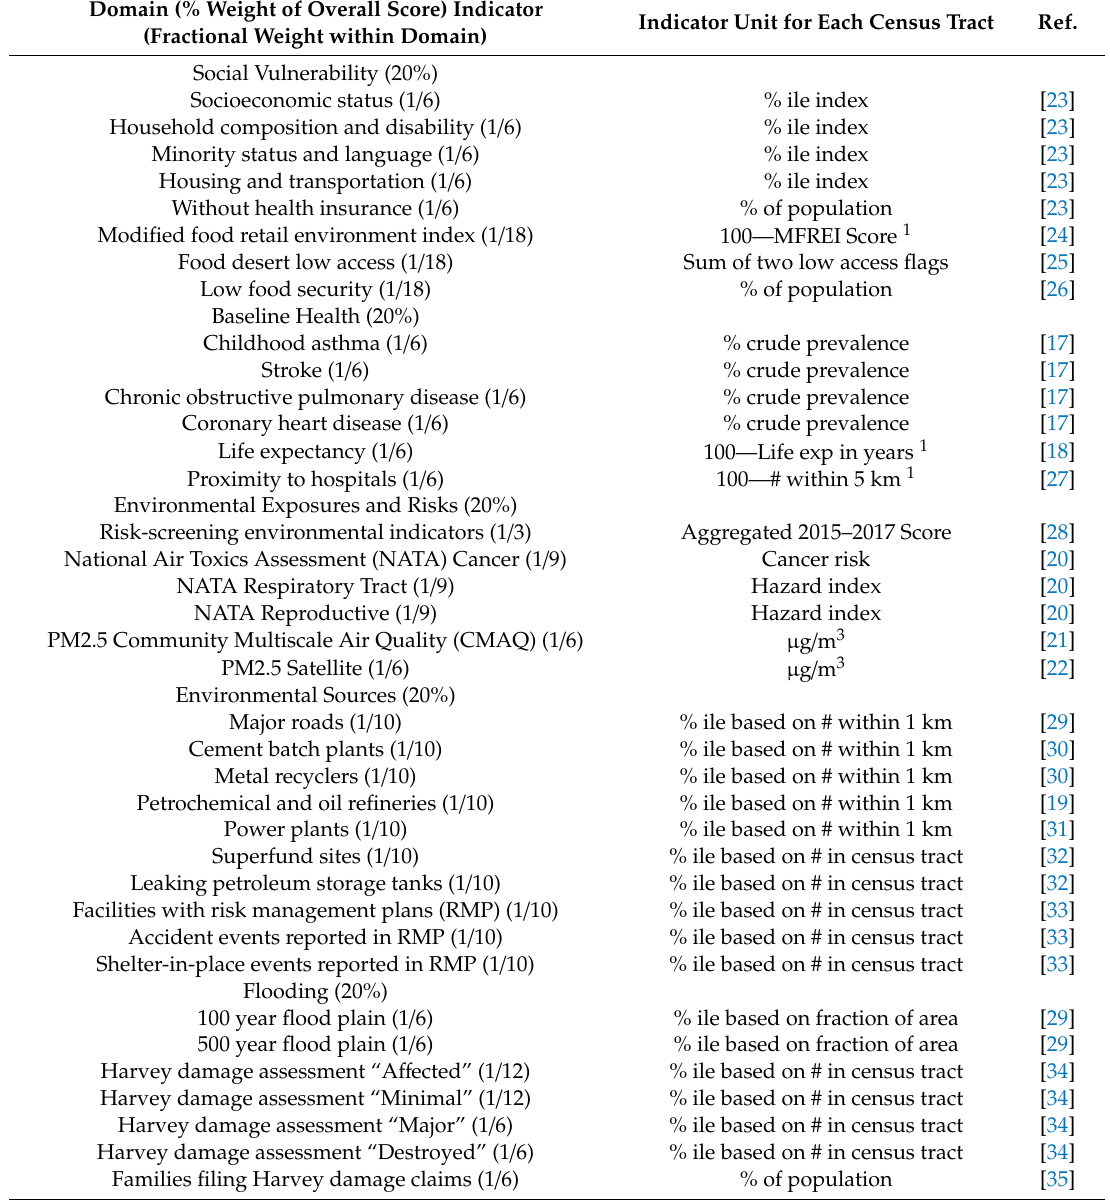
Table 1. Indicators and the domains of vulnerability incorporated into